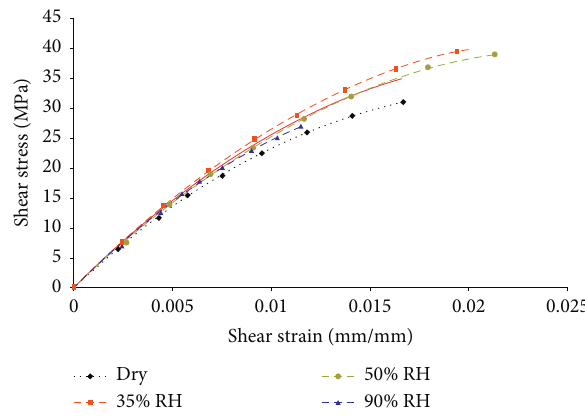
Figure 6: Shear stress-strain behavior of the flax/epoxy composite samples under different relative humidities